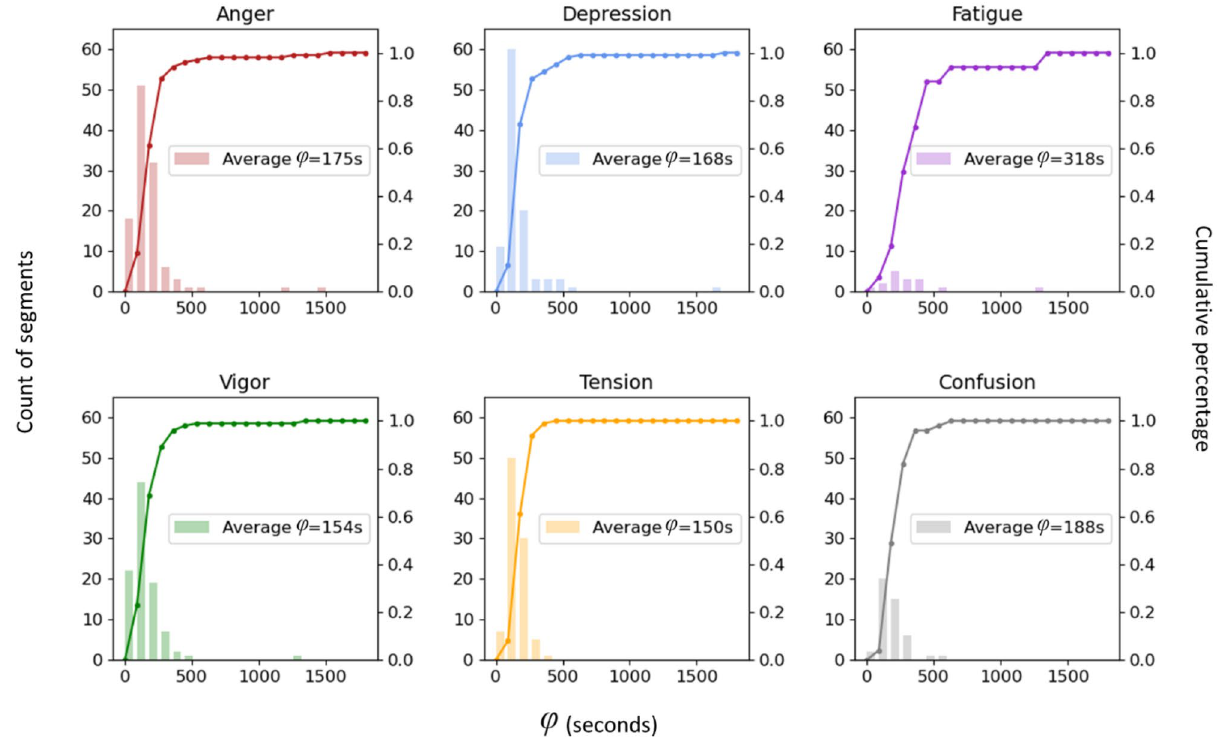
Figure 6. Histogram chart of memory period φ by emotion. The values of φ (ranges from 0 to 1800 s) are divided into 20 bins of the same size. The x-axis represents the memory period φ (in s) and y-axis represents the frequency distribution of the memory period. The dotted curves show the cumulative distribution function of the memory period. It is observed that the average memory periods for most emotions except for Fatigue are similar around 3